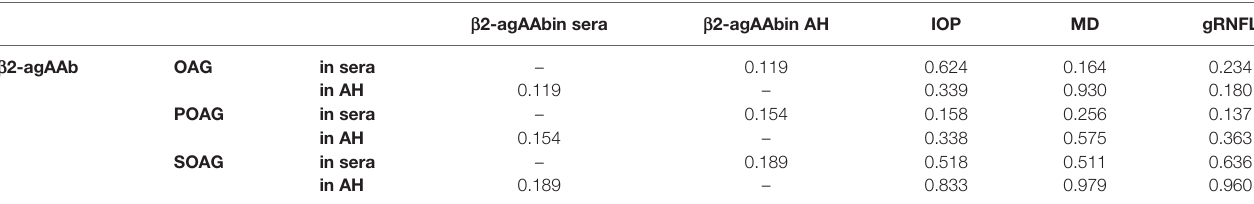
TABLE 2 | Correlation analysis of agonistic activities of b 2-agAAb in aqueous humor (AH) with their corresponding b 2-agAAb in sera, intraocular pressure (IOP), mean defect (MD), and global retinal nerve fi ber layer (gRFNL) for open-angle glaucoma (OAG), primary OAG (POAG), and secondary OAG patients (SOAG, exact p-values are shown): b 2-agAAbs were observed to be